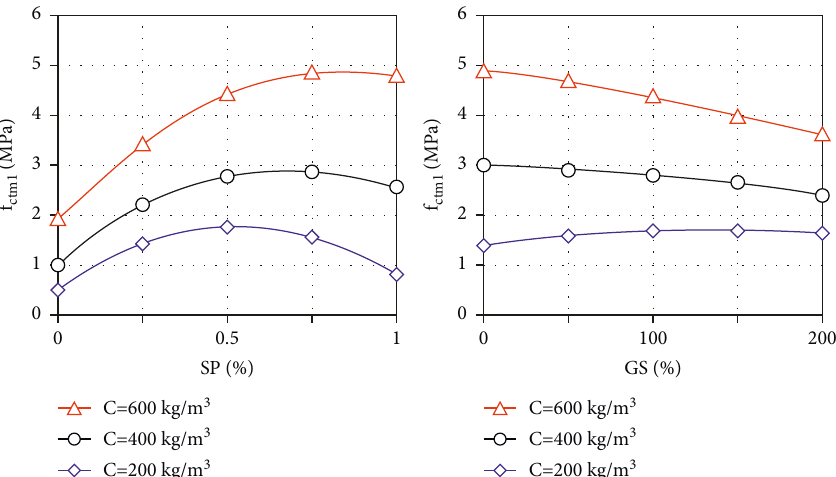
Figure 5: The influence of SP and blast furnace slag content at different cement consumption values on SCC tensile strength at day 1 (the third factor in graphs are at the average level according to Table